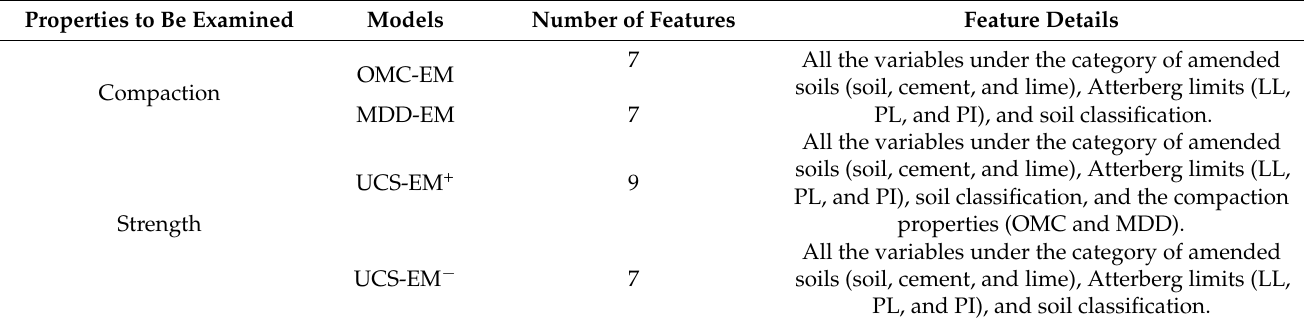
Table 3. Description of features considered in each